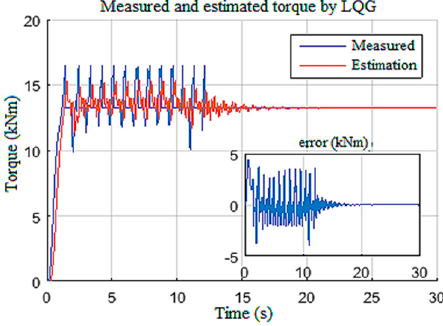
Figure 12. Torque on bit response for Scenario 1.